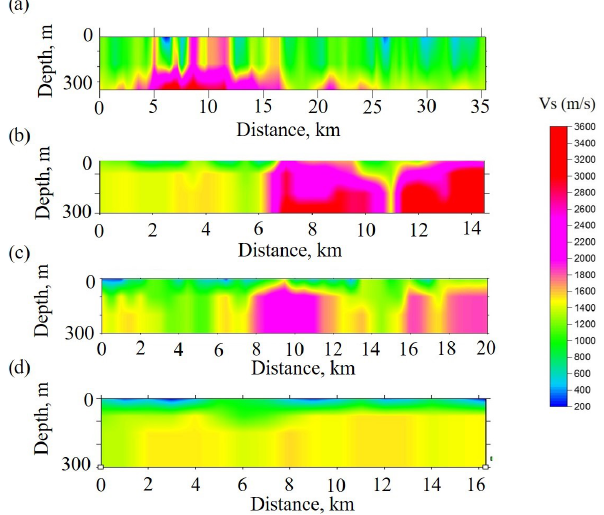
Figure 18. Velocity models calculated by inversion of dispersion curves, obtained by passive seismic interferometry for XSoDEx profiles shown in Fig. 1. (a) Pomokairantie; (b) Alaliesintie; (c) Sakatti; (d) Kuusivaarantie.